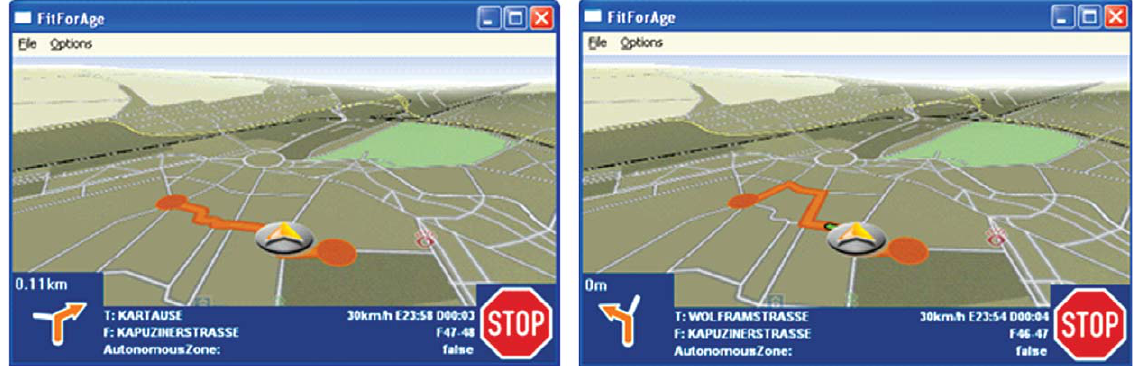
Fig. 14. Two example routes, left with no stairway penalty, right with stairway